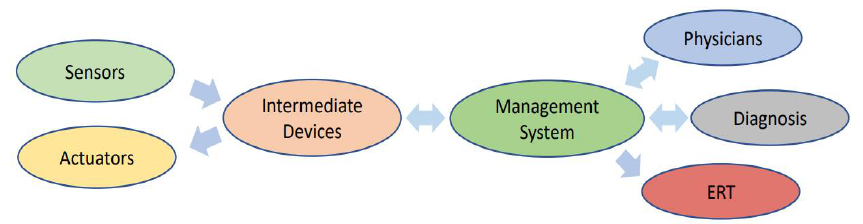
Figure 1. High-Level Architecture of IoHT Implementation .